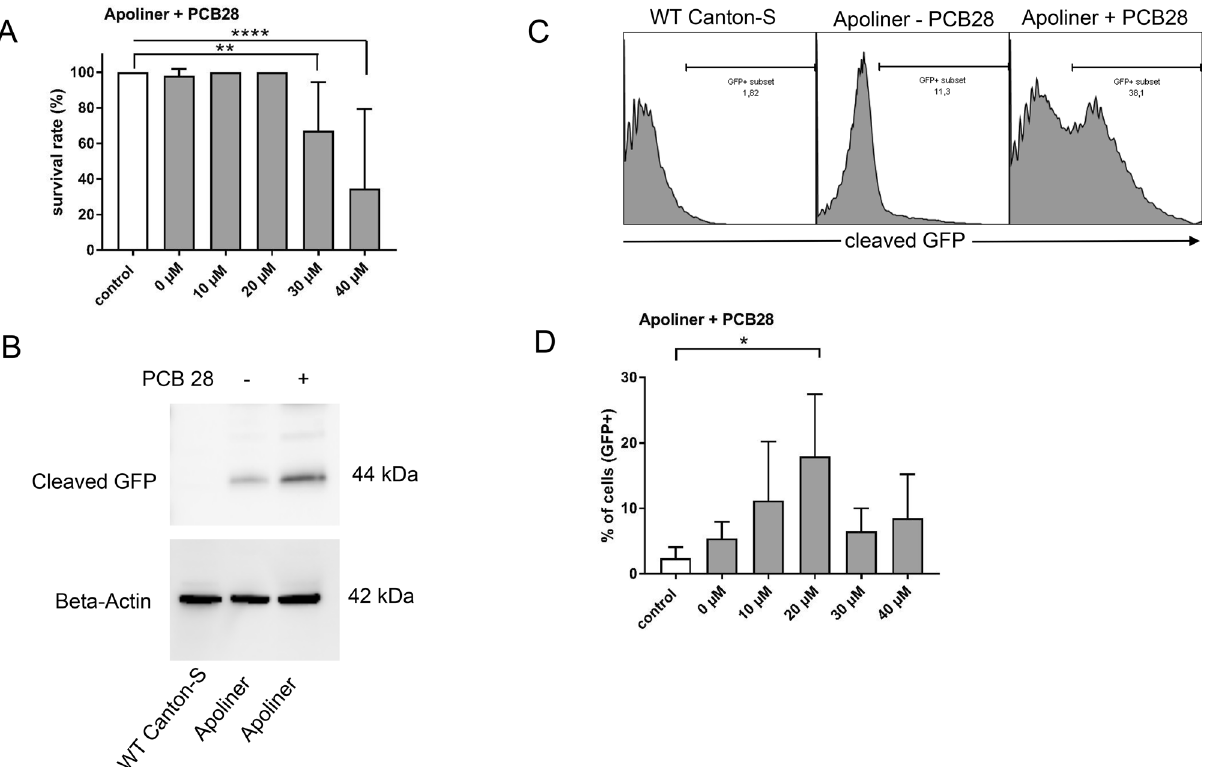
Figure 4. PCB 28 induces neuronal caspase activation prior to cell death and dying in Drosophila . ( A ) Wild type Canton-S (control, 0 µM PCB 28) and flies with a neuronal specific expression of the Apoliner biosensor were fed PCB 28 with the subsequent analysis of dead flies 24 h later. Mean ± SD of four different biological replicates each with a total of 12 flies are shown. ( B ) Western blot analysis of an apoptosis indicating GFP- containing fragment at 44 kDa after 4 h of feeding Apoliner expressing flies with PCB 28. Representative result from one experiment out of three is shown. ( C ) Flow cytometry analysis of the same flies which had been used for Western-blotting described in ( B ). ( D ) Flow cytometric quantification of the GFP signal in controls and carriers of the neuronally expressed biosensor. Mean values and standard deviation of 4 biological replicas, each with a total of 12 flies per replicate are shown. Differences were calculated by ANOVA and adjusted by posthoc Tukey-test for multiple measures. Statistical differences are as indicated (*p ≤ 0.05; **p ≤ 0,001; ****p ≤